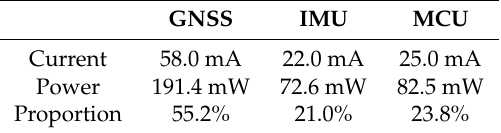
Table 1. Power consumption of each component for performing the baseline operation.